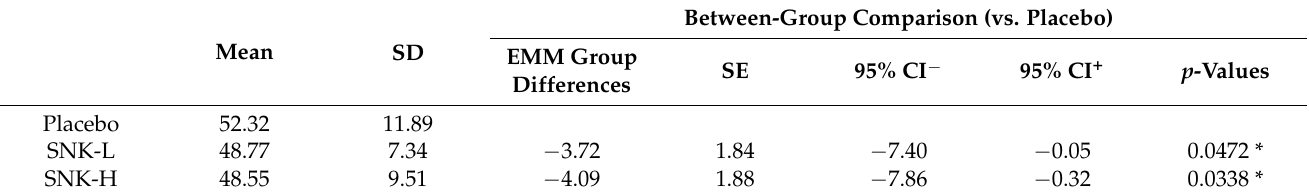
Table 3. Post-stress loading TMD scores after the 4-week intervention.